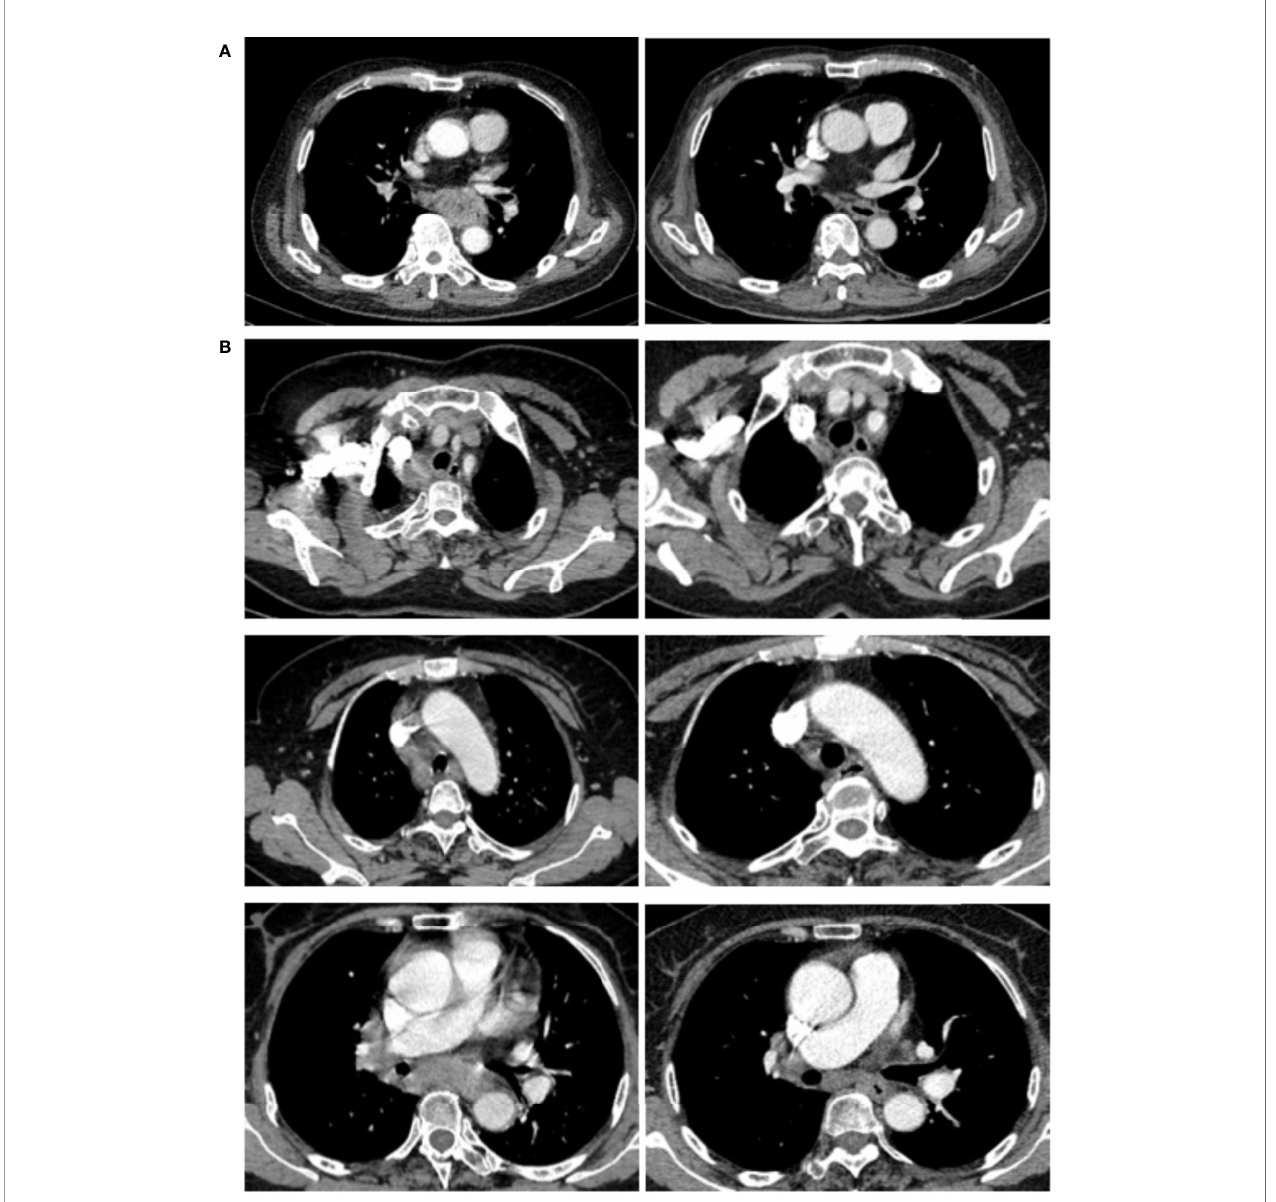
FIGURE 1 | Cases of radiological responses after neoadjuvant immune checkpoint inhibitors and chemotherapy. (A) This shows the radiological images of a 67- year-old male (patient 1) with a stage IVA ESCC before and after neoadjuvant treatment. This patient achieved pathological regression of 100% for esophageal lesion with no residual lymph node metastasis according to postoperative specimen (B) This shows the images of a 68-year-old female (patient 2), who had a stage IVA ESCC before neoadjuvant treatment. This patient had 100% pathological regression of the primary tumor but had residual metastatic lymph